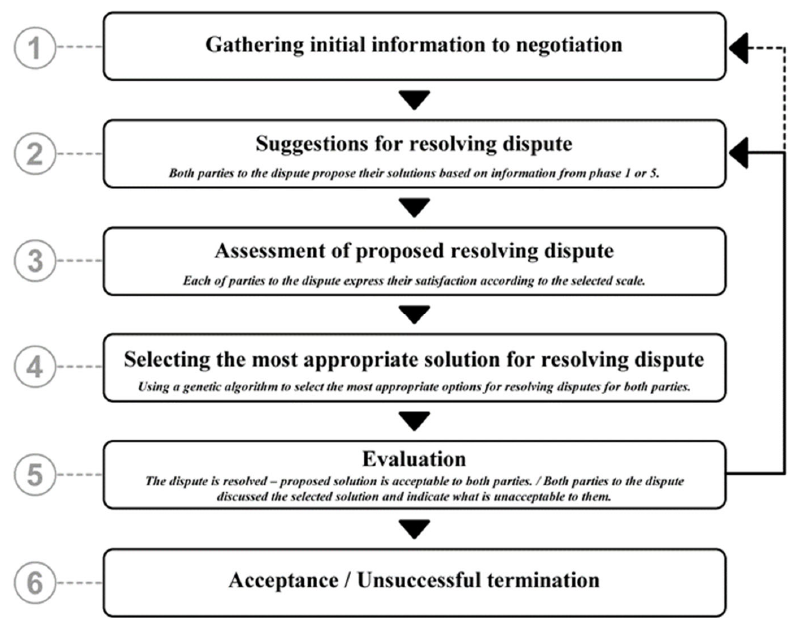
Figure 2. E ‐ NeGotiAtion method with GA involved in Phase 4. Figure 2. E-NeGotiAtion method with GA involved in Phase